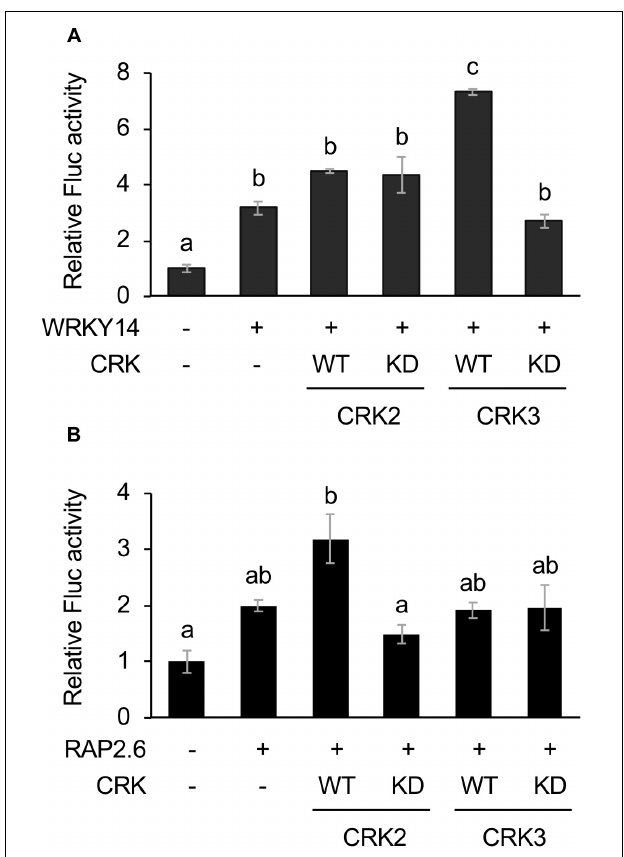
FIGURE 2 | Dual luciferase (LUC) activity mediated through CRK-activated WRKY14 or RAP2.6. Four inverted repeats of W-box or GCC-box fragment fused to a minimal TATA-box and a firefly LUC (Fluc) reporter gene. Transient activation of the reporter gene according to co-expression with (+) or without (-) WRKY14 (A) or RAP2.6 (B) , WT or kinase dead-mutant (KD) of CRK2 or CRK3 in Arabidopsis protoplast cells was assessed. Renilla luciferase (Rluc) activity was used to normalize for the efficiency of transformation. Data represent the mean and standard error ( n = 3). Means indicated by different small letters are significantly different, based on a one-way ANOVA with post hoc Tukey’s HSD ( P < 0.05).